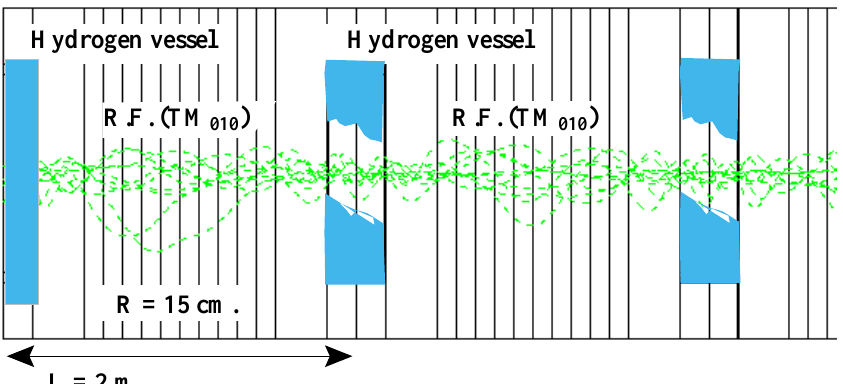
FIG. 25. (Color) GEANT simulation of muons traversing a section of the alternating solenoid cooling channel. The variation of the cells of the figure. magnetic field B z is shown for 1 1 2